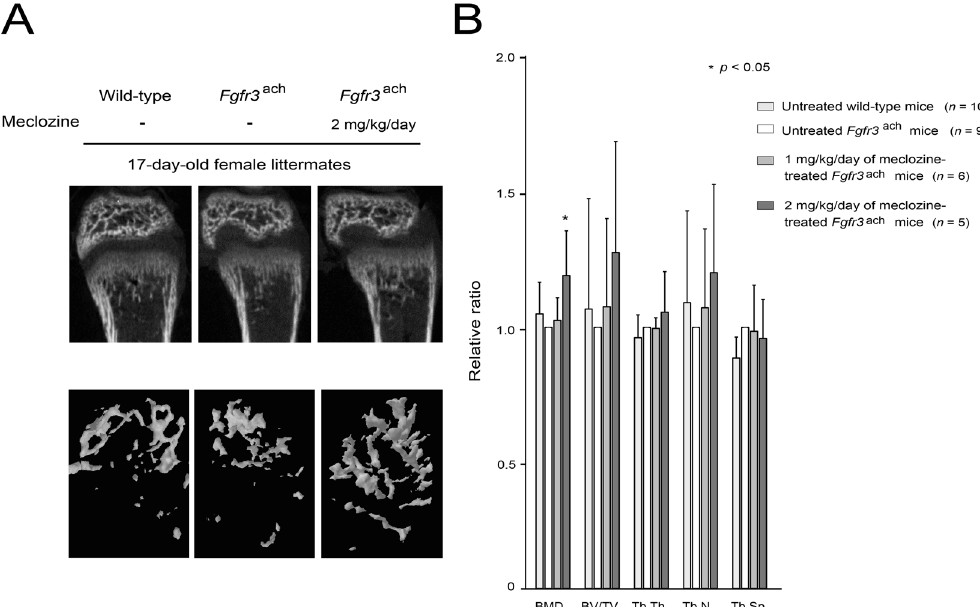
Figure 4. Bone mineral density is enhanced in meclozine-treated Fgfr3 ach mice. ( A ) Representative reconstructed micro-CT images of the distal femur at the end of treatment revealed that metaphyseal bone mineral density was increased after meclozine treatment. Upper panels show 2D images of the distal femur and lower panels show 3D images of metaphyseal trabecular bone. ( B ) The average relative ratio of bone mineral density (BMD) was increased after meclozine treatment while there were no statistical differences in bone volume/total volume (BV/TV), trabecular thickness (Tb.Th), trabecular number (Tb.N), and trabecular separation (Tb.Sp). Relative values were calculated based on those of untreated Fgfr3 ach mice. Mean and SD are indicated. Statistical significance was analyzed by the unpaired t test for each dose of meclozine-treated Fgfr3 ach mice ( n = 6 and 5 for 1 and 2 mg/kg/day of meclozine, respectively) or untreated wild-type mice ( n = 10) versus untreated Fgfr3 ach mice ( n =